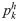
Example of hypothesis correction on a complex rhythm.The figure repeats all three elements from Fig 5: input (ri), original hypothesis projection (pkh) and corrected hypothesis projection (pkh+Δh). The input is now a complex rhythm where not all hypothesis projection times have a corresponding onset time (at 1000 and 3000 ms). The correction is now performed using the corrected prediction error (cek) for each projection event. The corrected prediction error is shown, at the bottom of the figure. The hypothesis projection lines (pkh) are extended downwards to match with correction error score. The corrected error is larger when the error is larger but goes back to zero when there is no onset event close to the projection event.